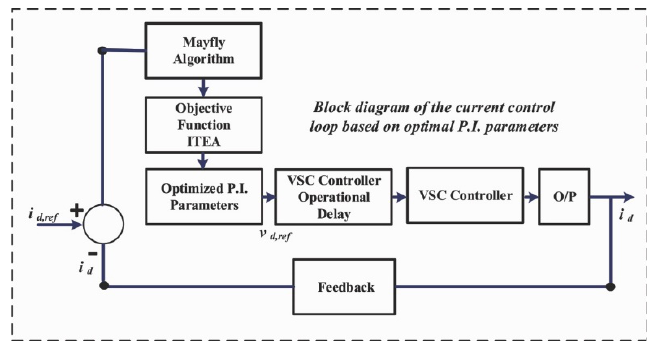
Figure 9. MA implementation of P.I. controllers .